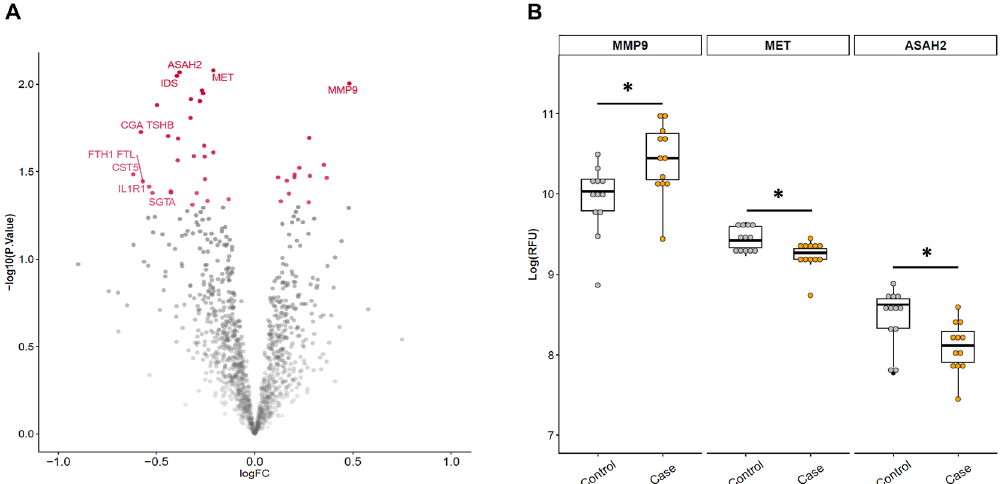
Figure 2. Discovery phase results. ( A ) Volcano plot of the discovery study. The y-axis represents − log10 p- value, and the x-axis represents the log2 fold change. Values greater or less than 0 indicate upregulated and downregulated genes, respectively. Color and opacity indicate whether features had a significant nominal p -value (red and opaque) or not significant (grey and transparent). Labeled features are those with a nominal p -value < 0.05 and |logFC|> 0.5 or p -value < 0.01. ( B ) Boxplots of RFU levels of the three selected protein candidates replicated from the discovery study (n = 24). The y-axis represents log(RFU) and the x-axis represents the group (controls, grey; cases, orange). *: P -value < 0.01. ASAH2, neutral ceramidase; MET, hepatocyte growth factor receptor; MMP9, matrix metalloproteinase-9; RFU, relative fluorescence units.